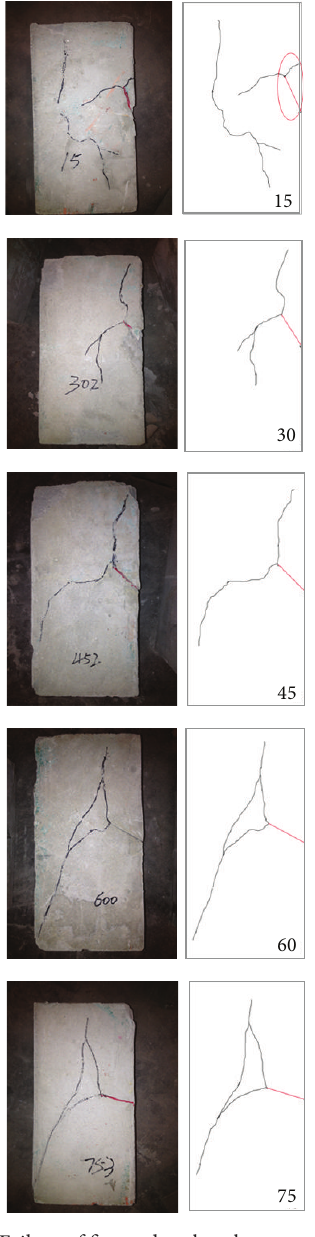
Figure 7: Failure of fissured rocks: photos and